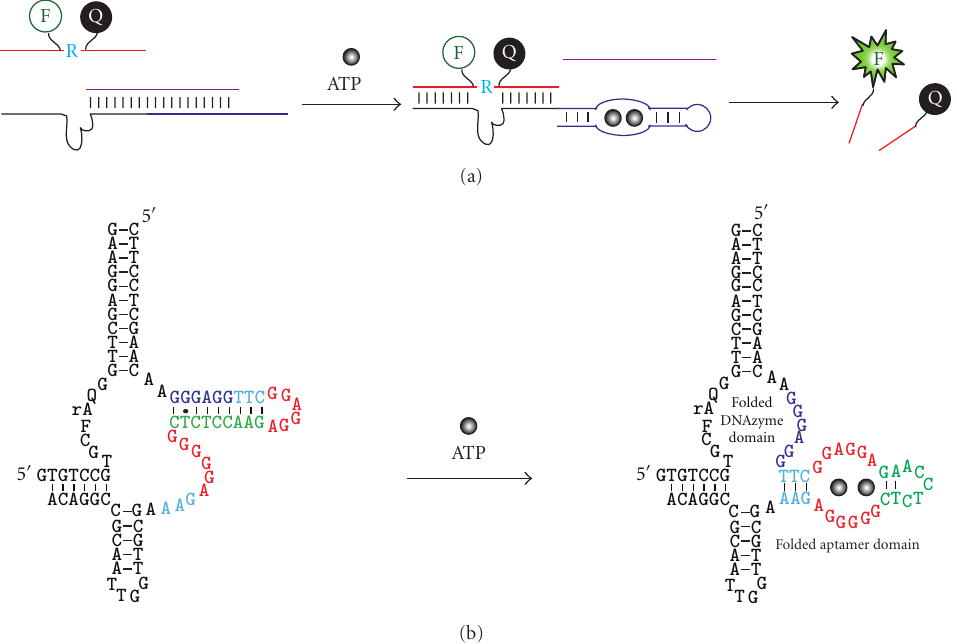
Figure 6: Engineering fluorescent RNase aptazymes by rational design. (a) The use of a regulatory oligonucleotide. The DNAzyme (black line) is joined to an ATP-binding DNA aptamer (blue line) and the combined sequence can form a duplex structure with a regulatory oligonucleotide (purple strand), which prevents the DNAzyme domain from binding the fluorogenic substrate. Binding of ATP to the aptamer domain causes the release of the regulatory oligonucleotide, freeing up the DNAzyme for binding and cleaving the substrate. (b) An ATP-responsive DNAzyme with internal regulatory nucleotides. The DNAzyme is designed from pH6DZ1 and the same ATP-binding aptamer. Nucleotides in the sensor sequence are color-coded for easy tracking of their relative positions in the two alternative structures. In the absence of ATP, the aptamer is designed to form an inhibitory duplex with the catalytic core; in the presence of ATP, the aptamer pulls away from the DNAzyme, which activates the DNAzyme leading to the generation of a fluorescent signal.